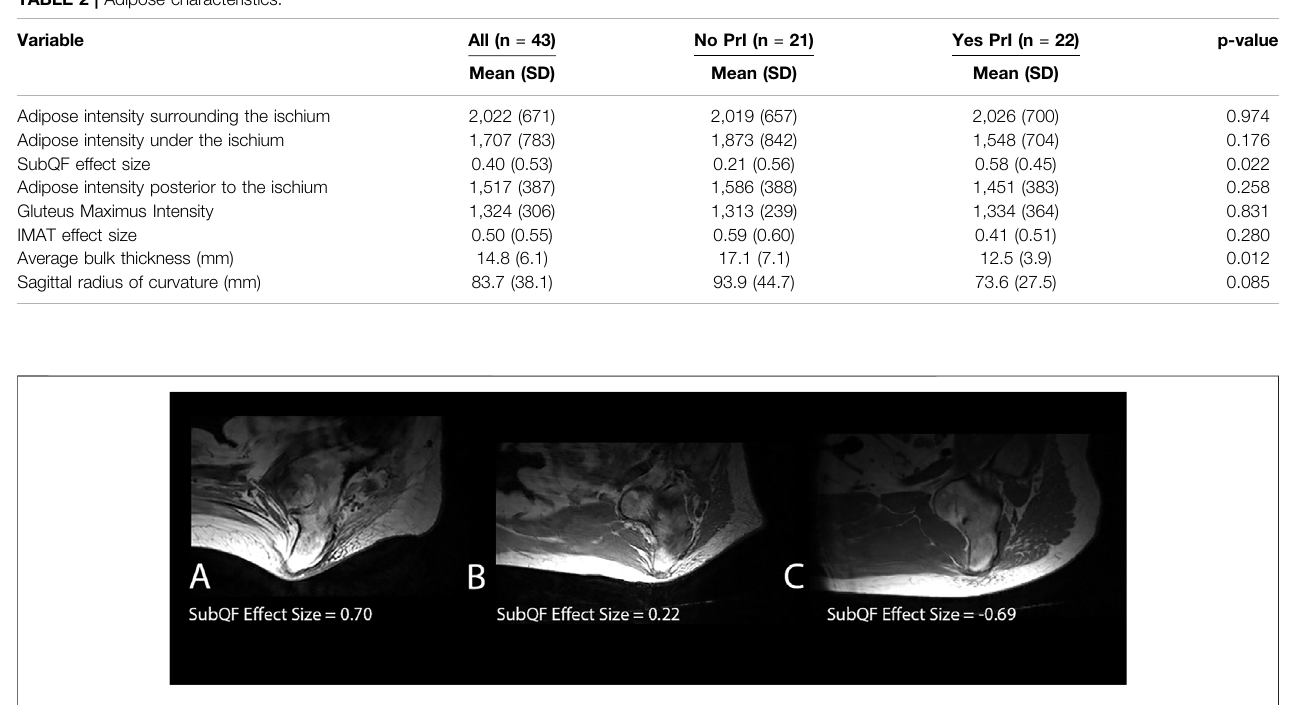
FIGURE 4 | Examples of subjects with different SubQF effect sizes. Subject A had a SubQF effect size of 0.7, indicating darker adipose under the ischium than surroundingtheischium,whilesubjectBhadaSubQFeffectsizeof0.22,indicatingadiposeundertheischiumwasonlyslightlydarkerthansurroundingischium.Subject